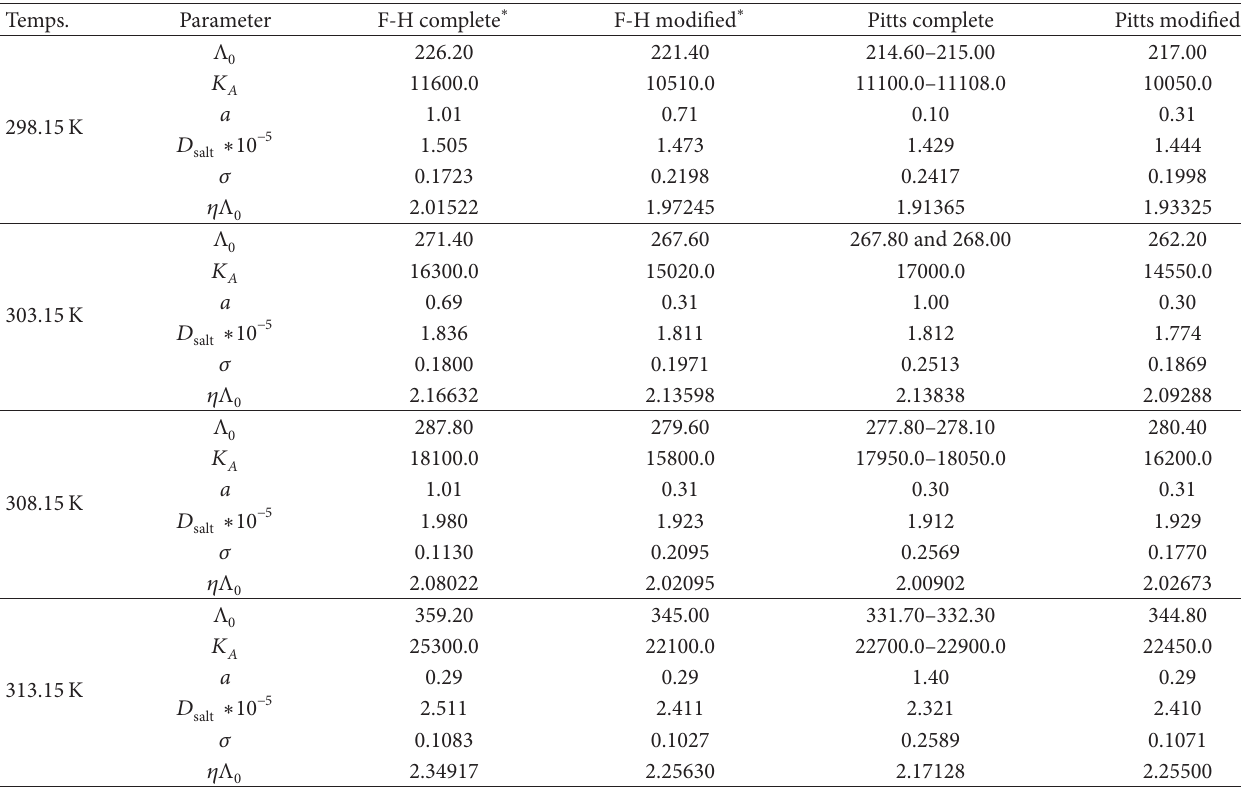
T 6: Best �t results for